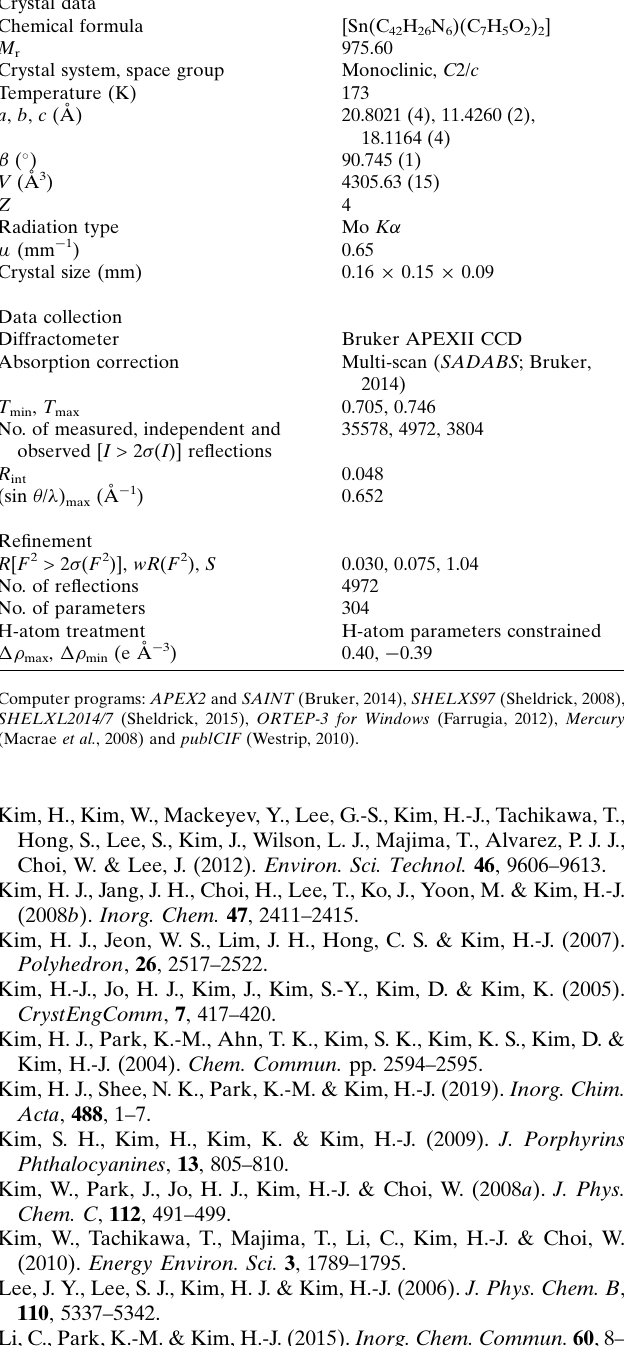
Table 3 Experimental details. Crystal data Chemical formula